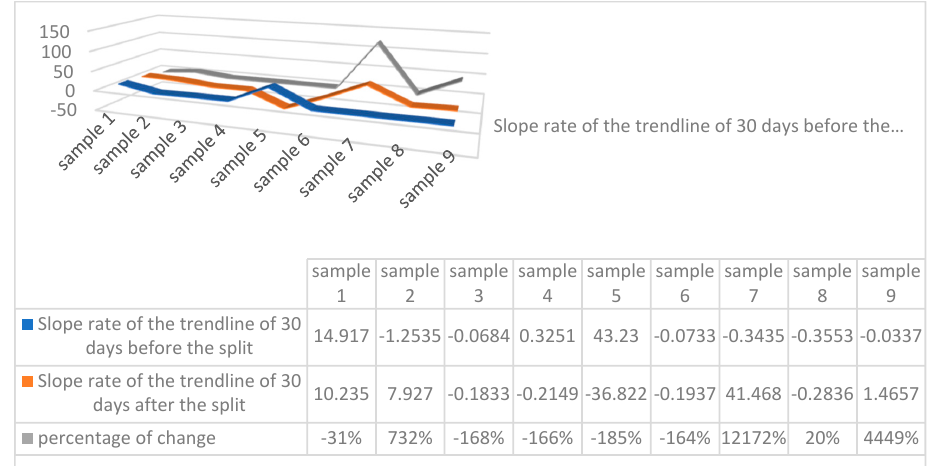
Figure 4 . Slopes for trendlines over 30 days. Figure 4. Slopes for trendlines over 30 days.